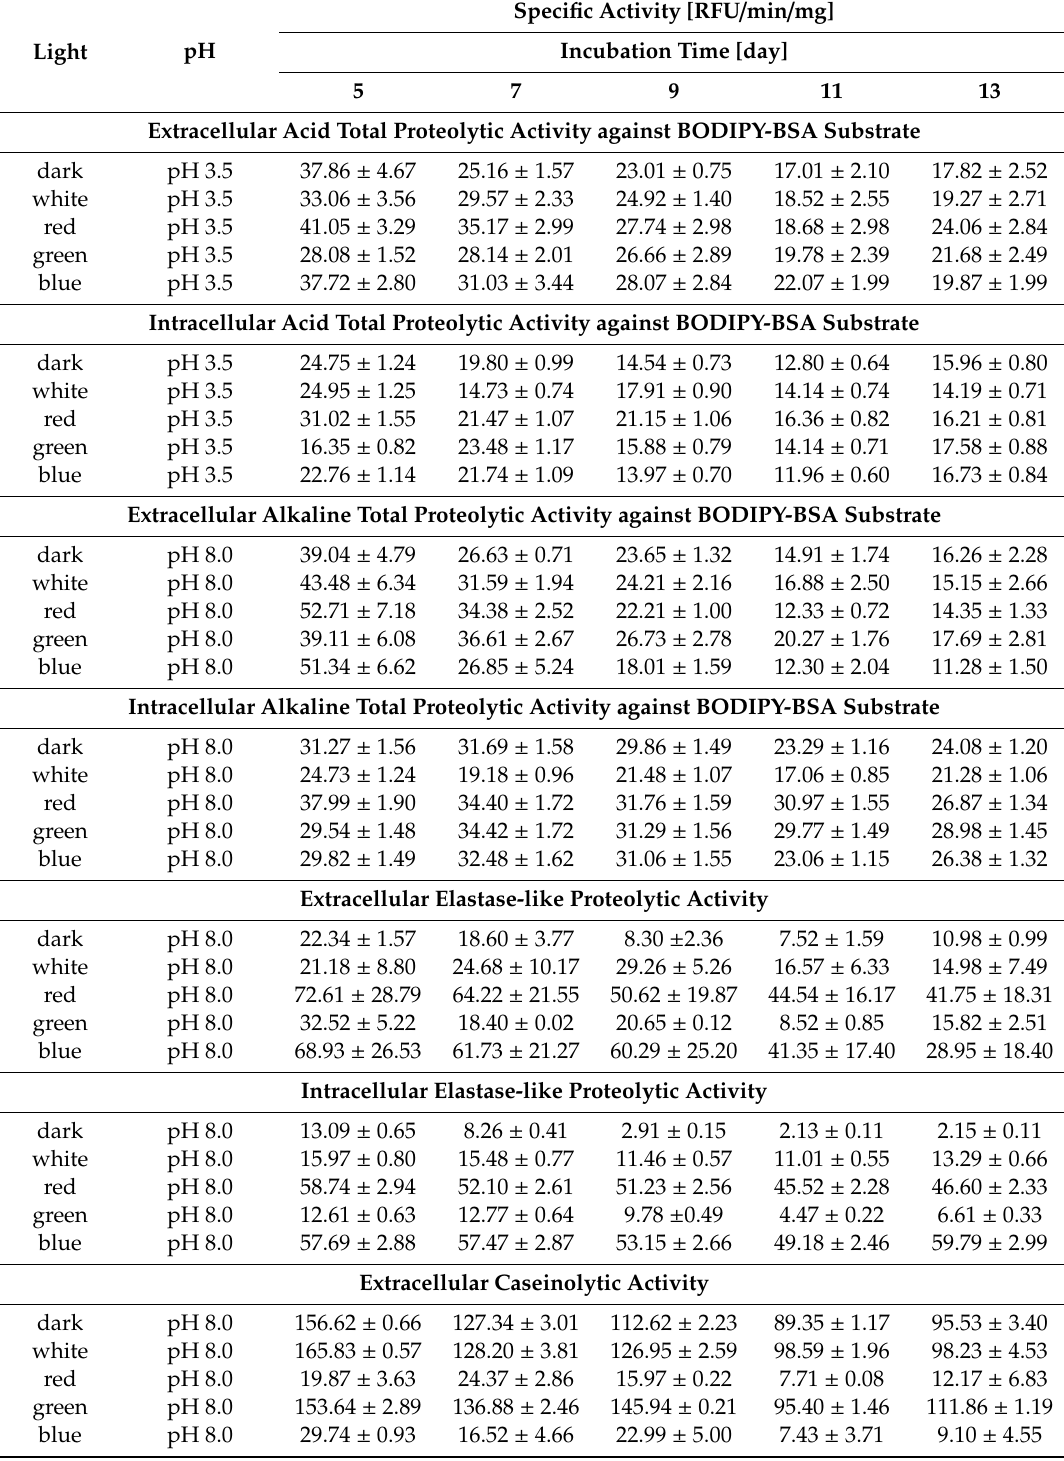
Table 2. Total proteolytic activities of acid and alkaline proteases measured against fluorogenic substrates (BODIPY-BSA, BODIPY-elastin and BODIPY-casein) detected in the culture extracts and clear supernatants of mycelium homogenates of C. unicolor growing in di ff erent lighting conditions.